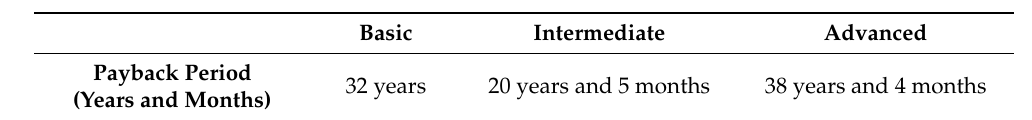
Table 16. Payback period